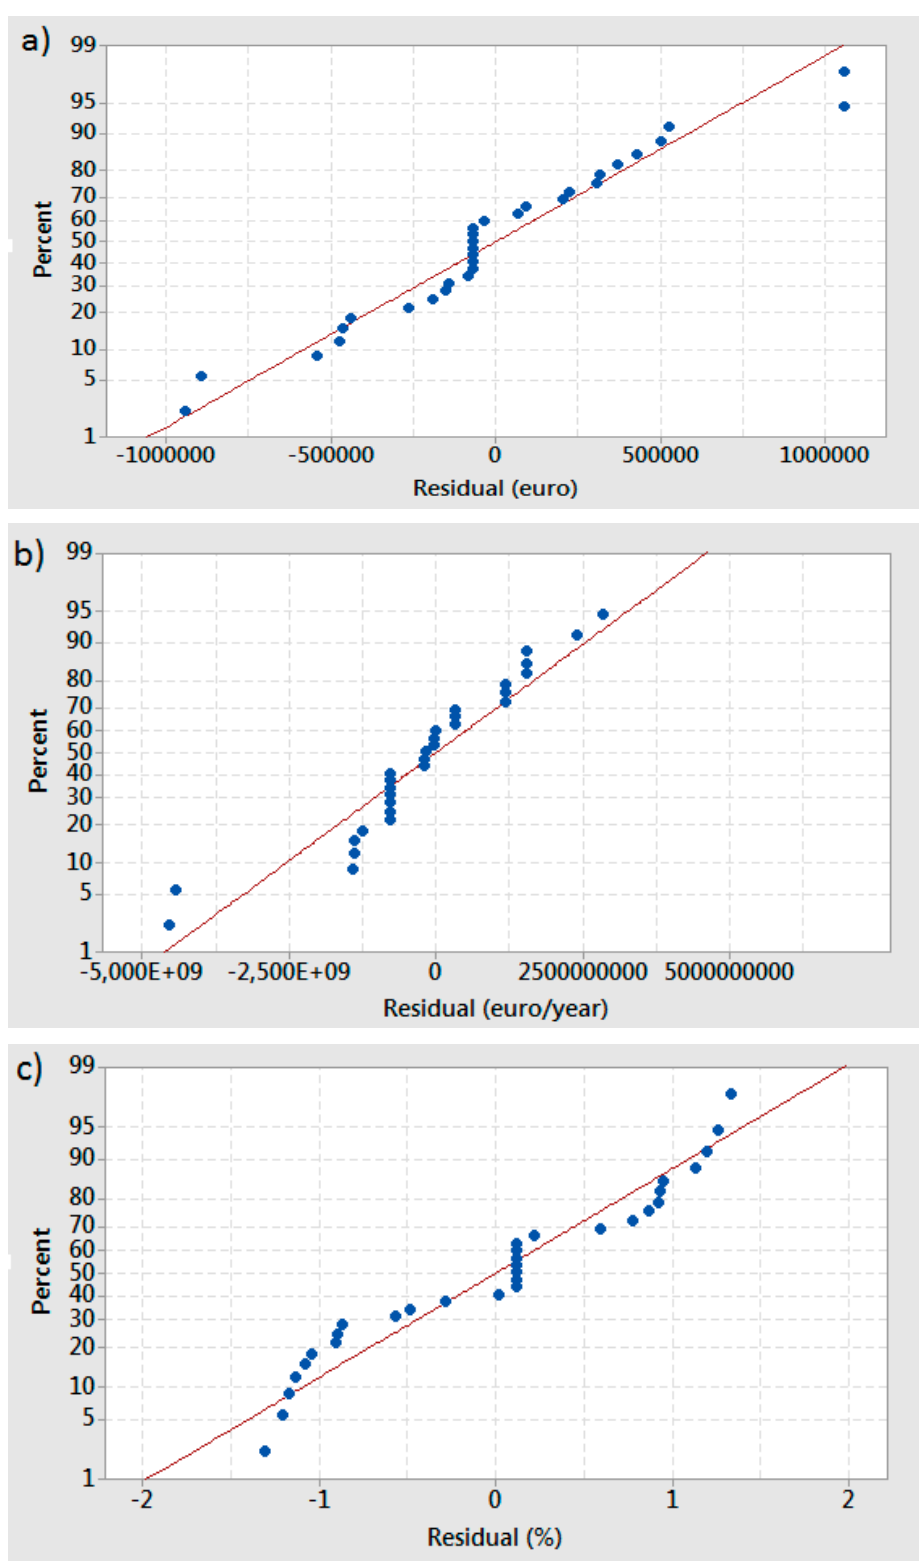
Figure 4. Normal probability plot of residual for: ( a ) CAPEX costs; ( b ) OPEX costs; ( c ) percentage of carbon dioxide removal.